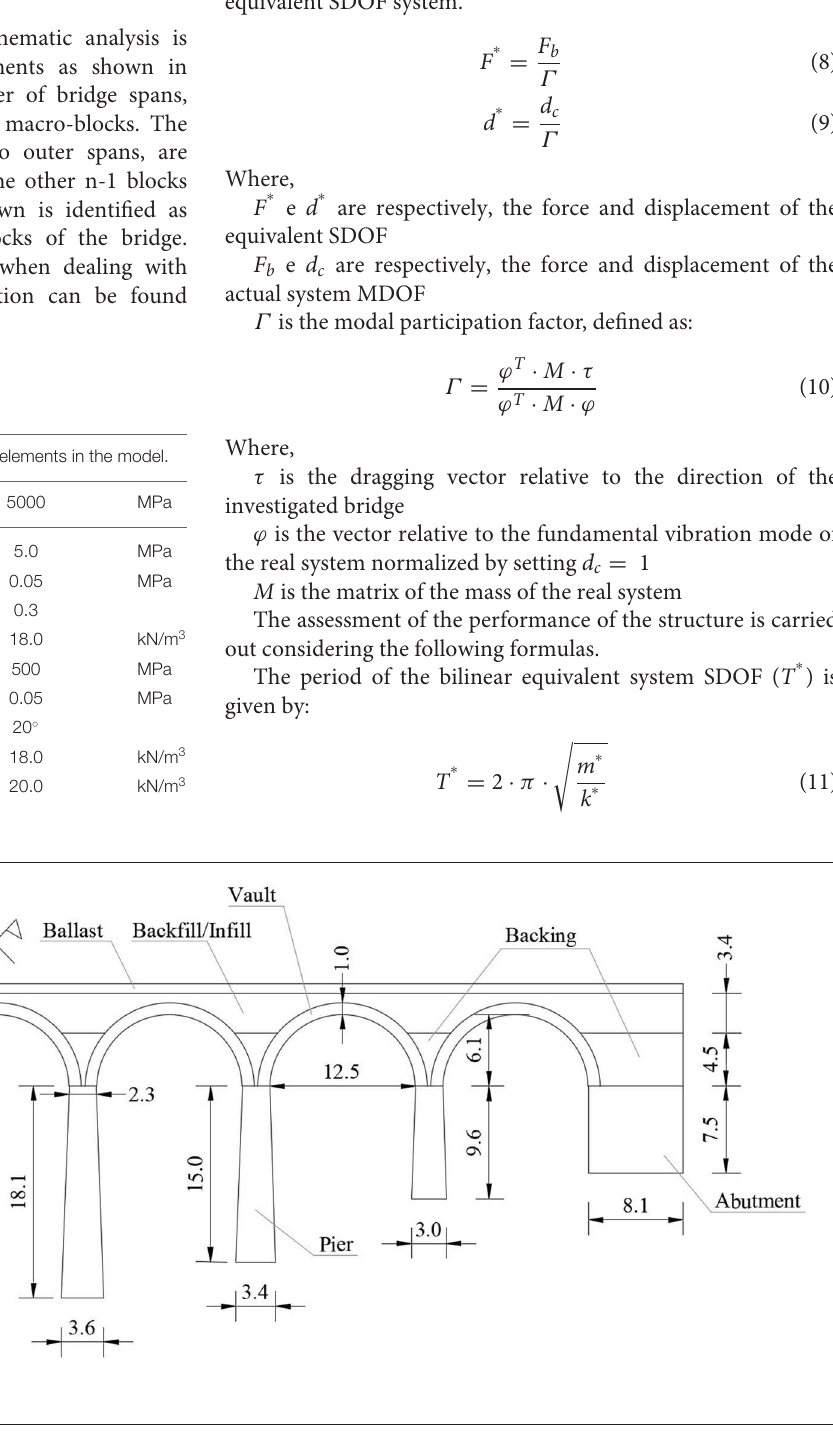
Frontiers in Built Environment |